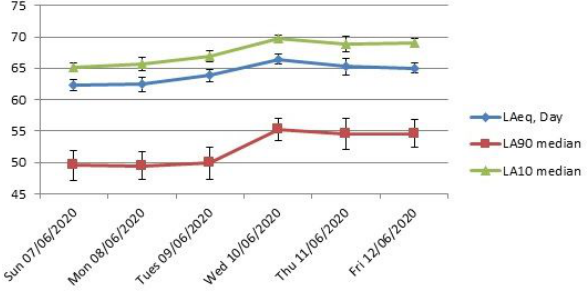
Figure 8: Case Study B: Daytime noise levels +/ − 1 standard devia-